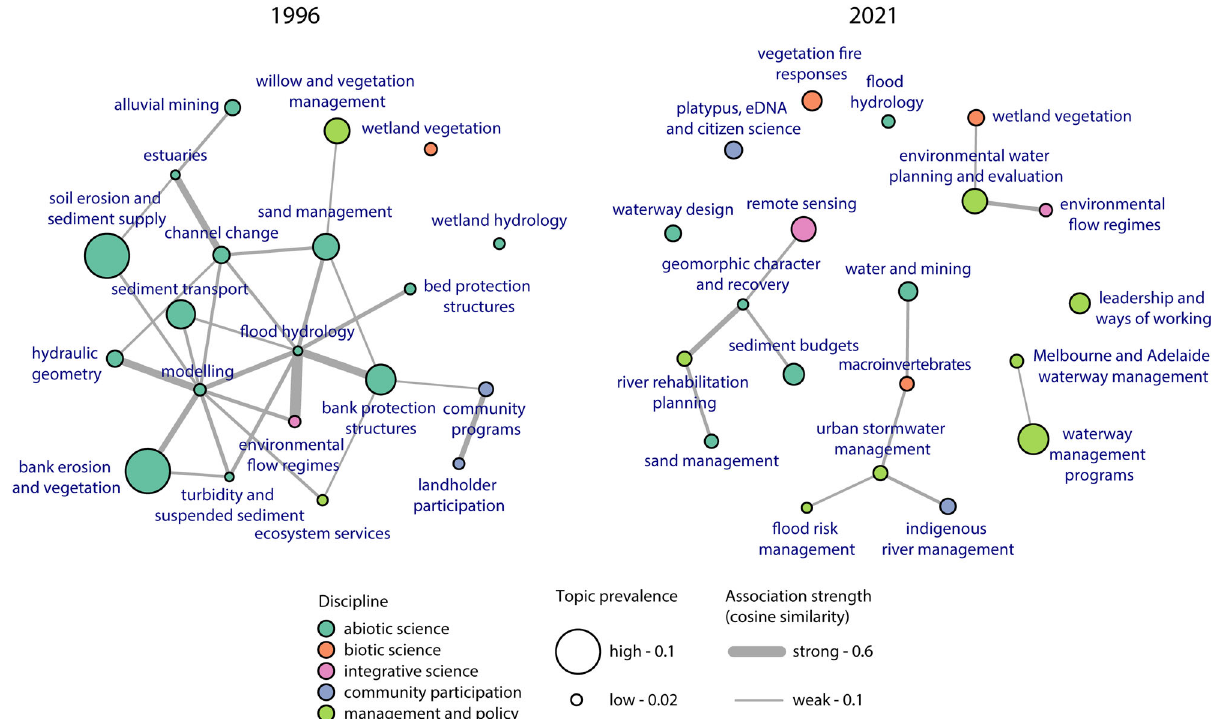
Fig. 6 Associations between top 20 highest prevalence topics were stronger in 1996 than 2021. Association strength, calculated as cosine similarity between vectors of each topic ’ s prevalence in each paper, is indicated by line weight. In 1996, strong associations mostly occurred between topics in the same domain (i.e., abiotic science), whereas in 2021, associations were mostly between different groups including management/policy and community, indicating stronger transdisciplinarity. Node diameter is scaled by topic prevalence, and node colour indicates discipline (abiotic science in dark green, biotic science in orange, community participation in purple, integrative science in pink, management and policy in light green). Detailed topic descriptions are presented in Supplementary Table